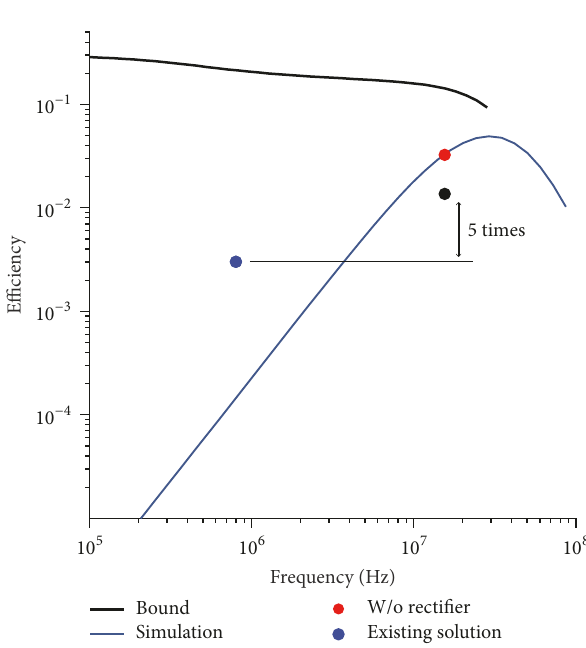
Figure 7: Measured power transfer efficiency versus the simulation and the bound. By increasing the operating frequency, the efficiency improved 5-fold compared to the existing